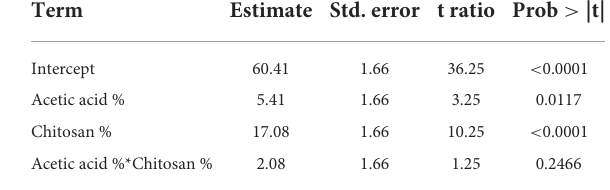
TABLE 7 Estimation of mathematical model parameters of the experimental design related to pigmentation stability of